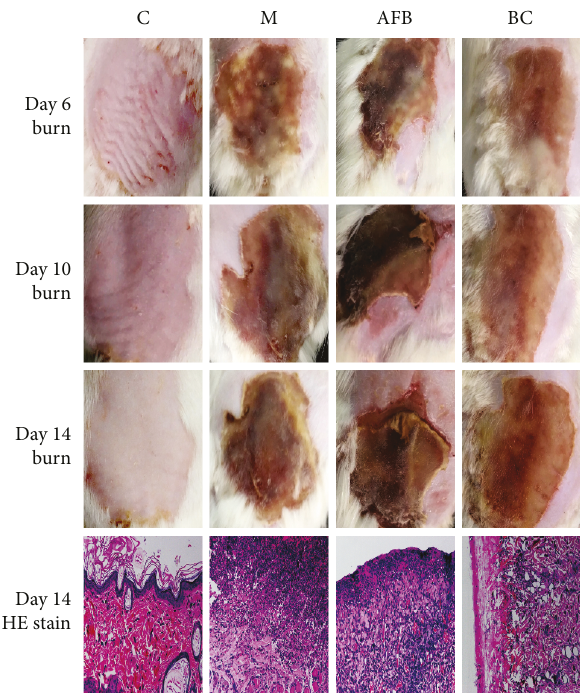
Figure 2: Treatment of the Aloe-fermented liquid on burn rats using morphology evaluation (days 6, 10, and 14) and histological evaluation (day 14). C, control group; M, model group; AFB: aloe-fermented liquid group; BC: burn cream